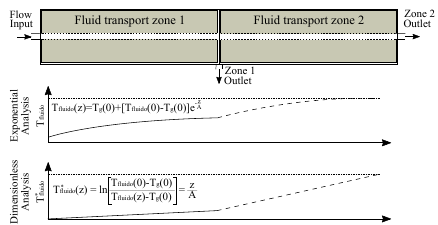
Figure 4. Exponential and dimensionless temperature behavior related to the prototype-well fluid transport zones.